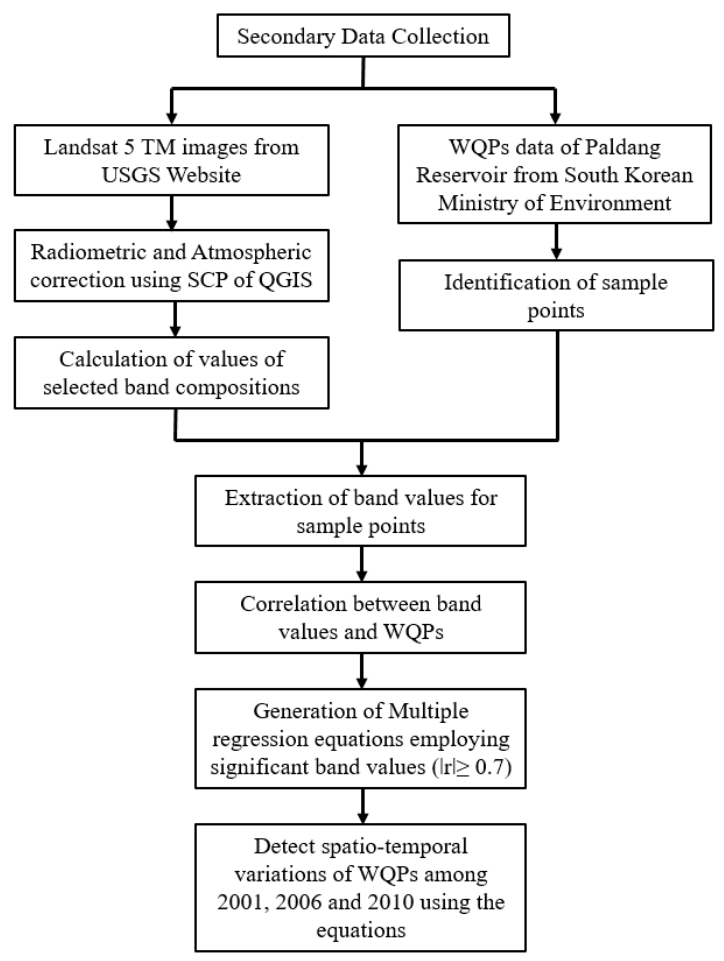
Figure 2. Methodological flow chart of the